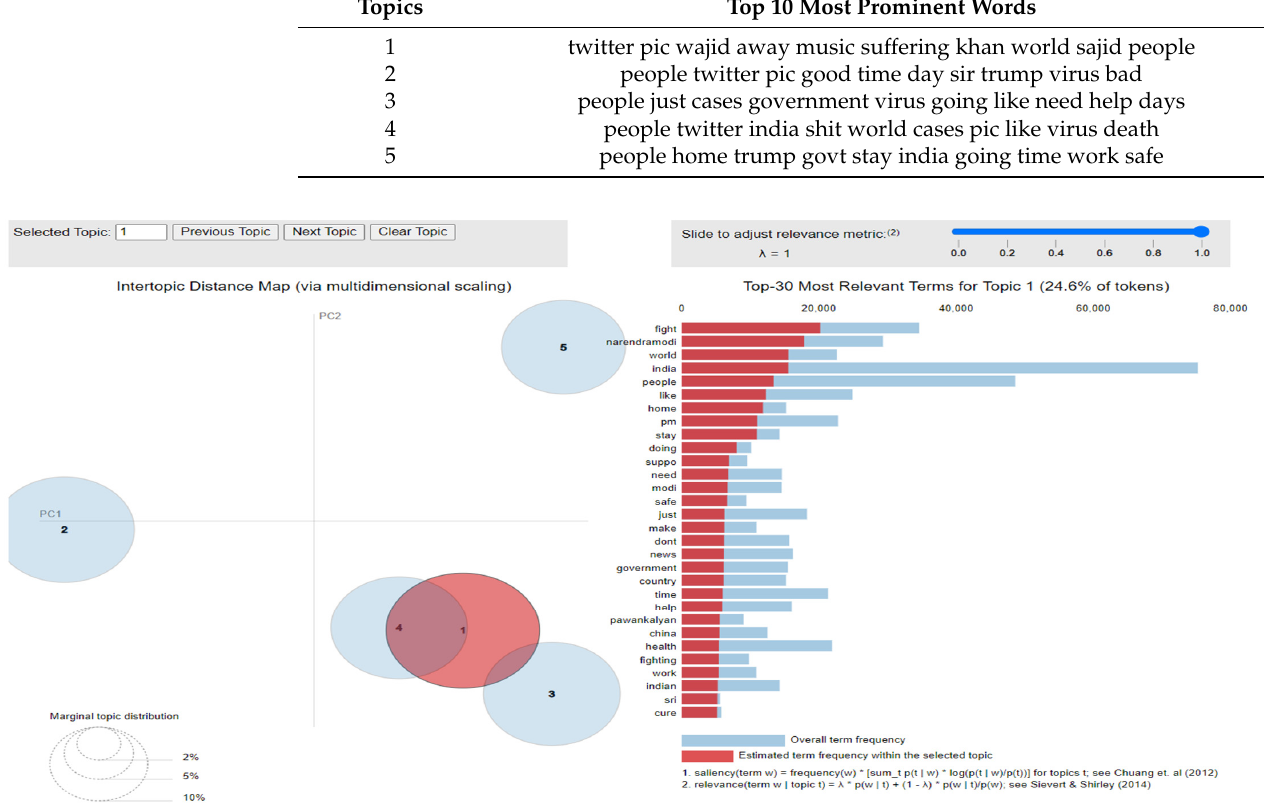
Figure 10. Inter-topic distance map for first dataset.